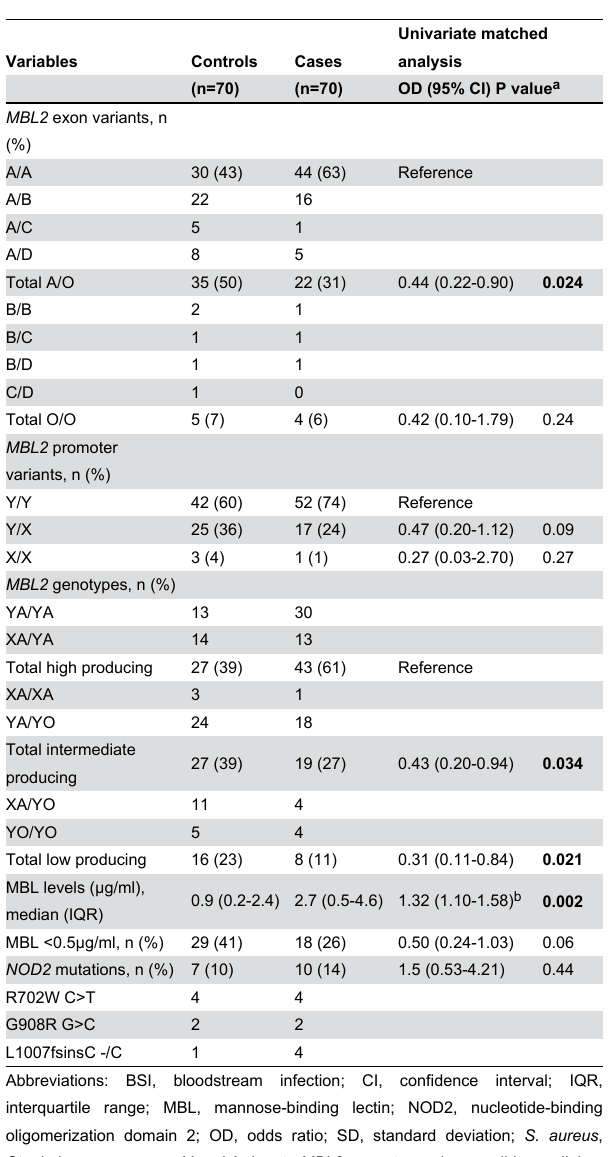
Table 2. Analysis of clinical characteristics as predisposing risk factors for S. aureus BSI.